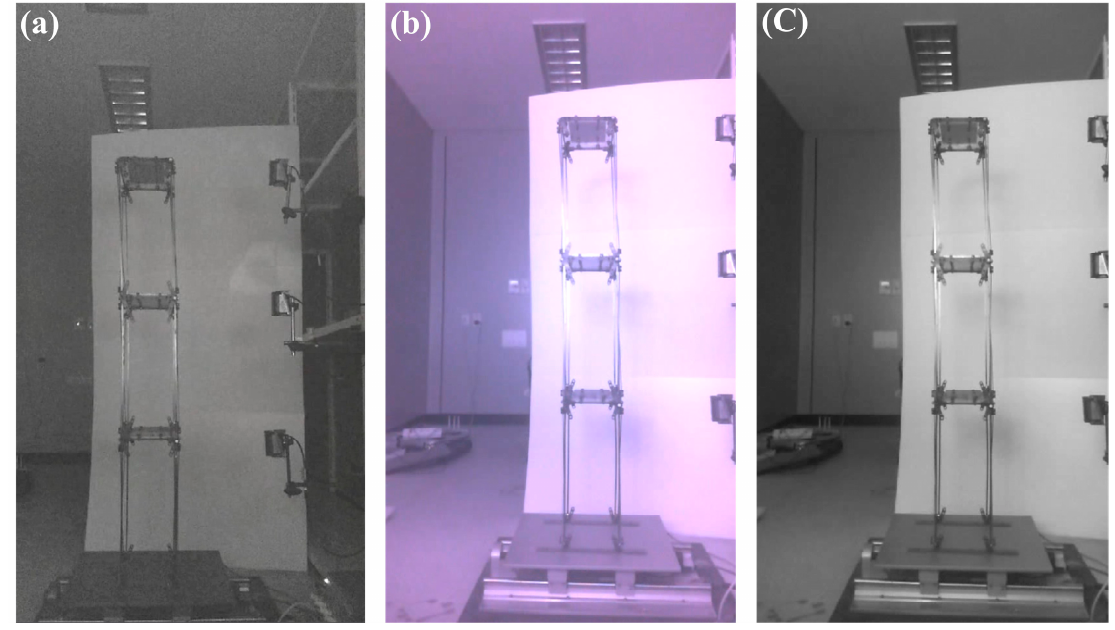
Figure 6. Real images of scaled model using shake table experiment taken into ( a ) general LifeCam HD-5000, ( b ) LifeCam HD-5000 with IR pass filter, ( c ) gray-scale image of LifeCam HD-5000 with IR pass filter.